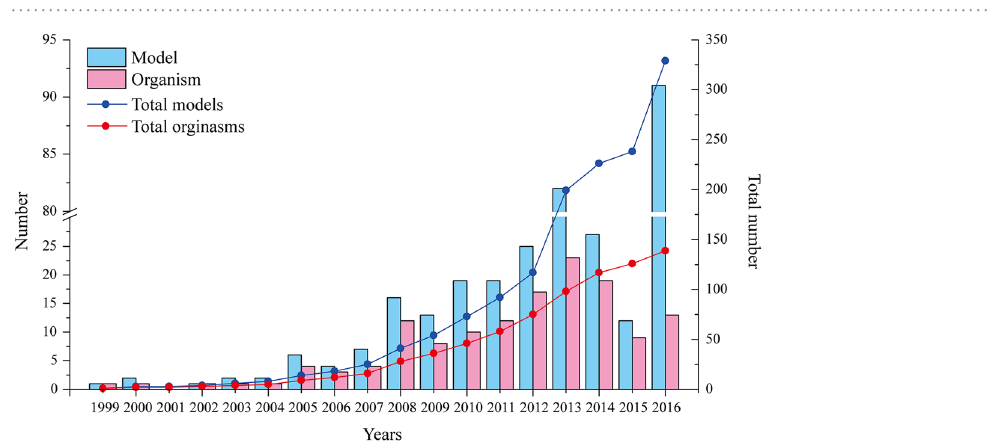
Figure 6. The development of GSMMs from 1999 to